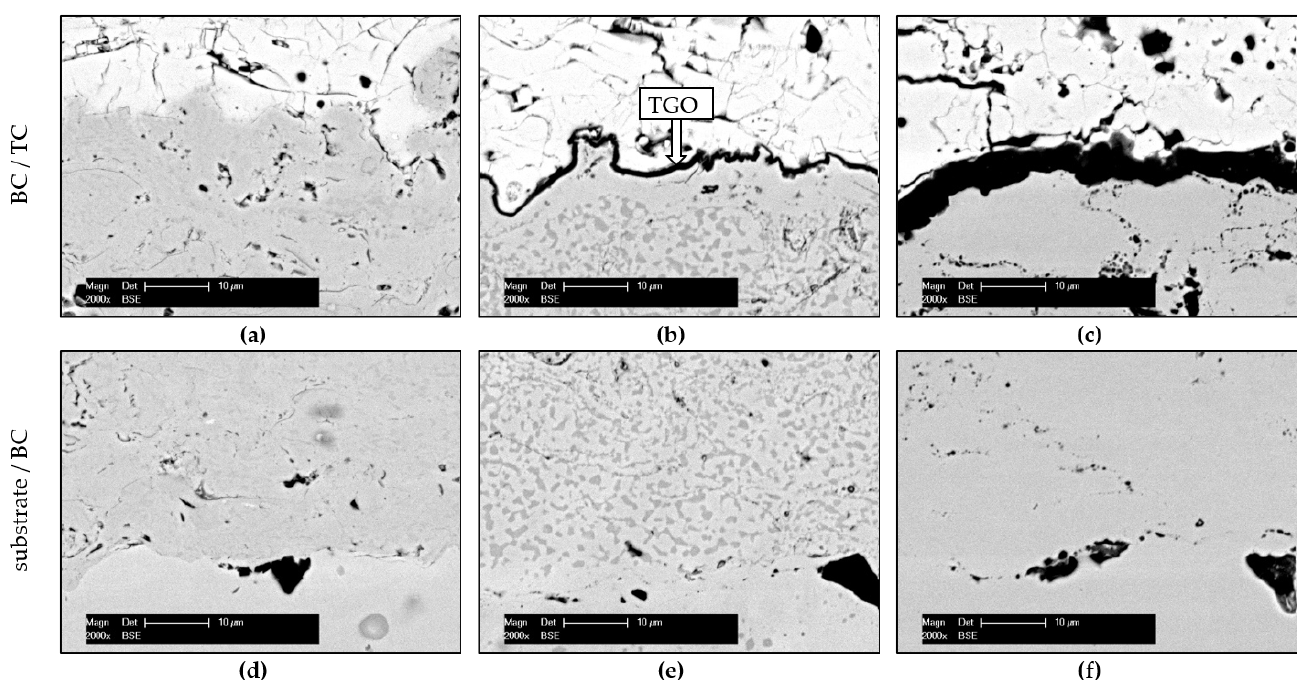
Figure 8. Cross-section SEM BSE micrographs of the TBC system ( a , d ) as-sprayed, ( b , e ) heat-treated (t 900°C = 10 h), and ( c , f ) isothermally oxidized (t 900°C = 1200 h).